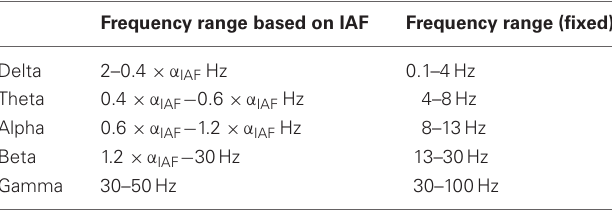
Table 1 | Comparison between fixed frequency bands and ranges based on